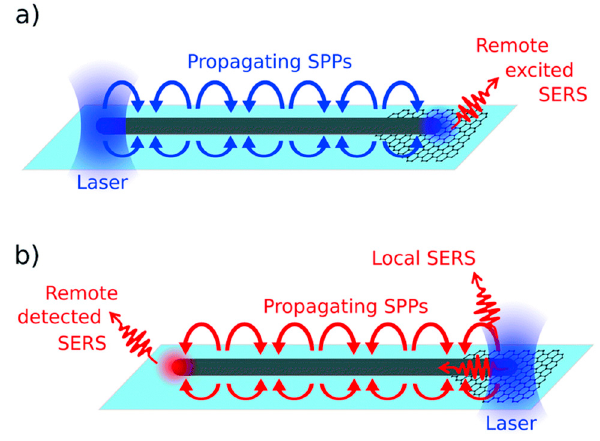
Figure 29. ( a ) Remote SERS excitation; ( b ) remote SERS detection. A commercial silver nanowire works as a waveguide and a graphene sheet is used for generating the SERS signal. Reproduced with permission from Coca-López et al. [396]. Copyright (2018) the Royal Society of Chemistry.